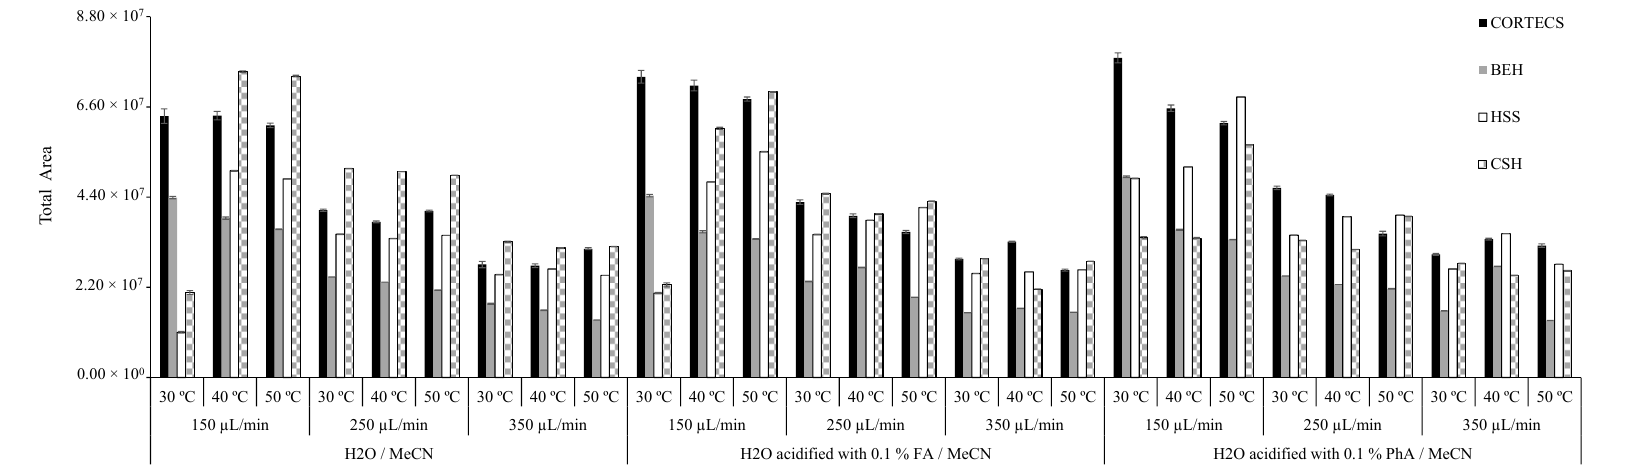
Figure 5. Optimization of chromatographic conditions in different analytical columns.